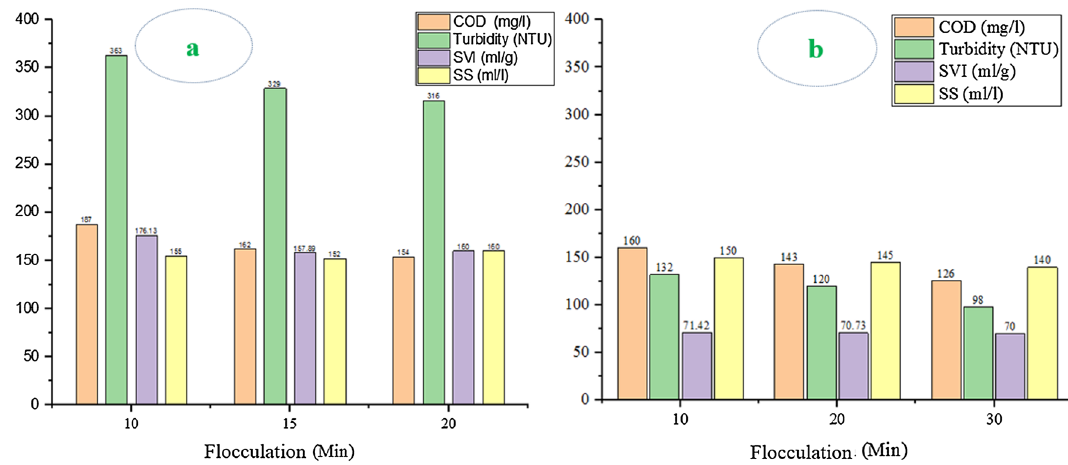
Fig. 3 Effect of Flocculation time on COD, turbidity, SVI, and SS a ozonation = 15 min and b non-ozonation. (Polymer concentration = 30 gr/ dry SL, coagulation time = 30 s, and settling time = (30)